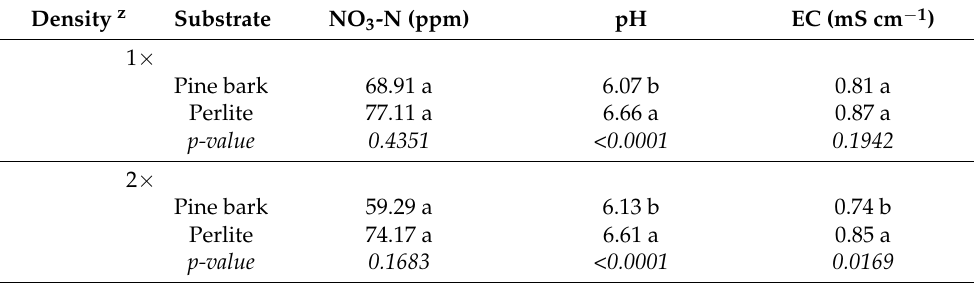
Table 2. Simple effects of substrate for each planting density level on leachate NO 3 -N, pH, and EC. Data collected from Dutch bucket drainage in